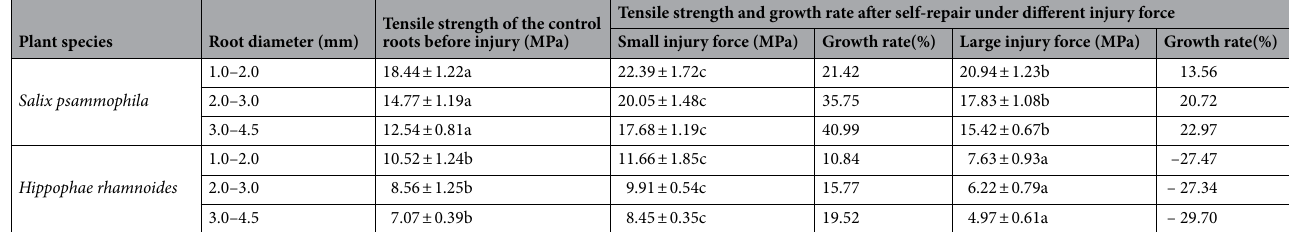
Table 4. The differences in tensile strength between 2 plants roots after self-repair and that of before injured.